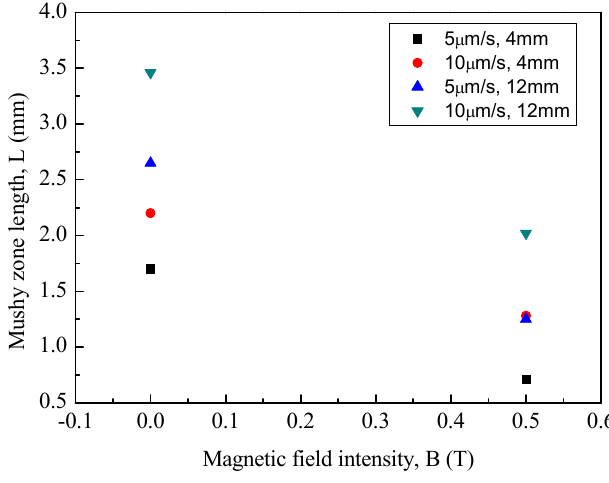
Figure 3. Mushy zone length as a function of magnetic field intensity.